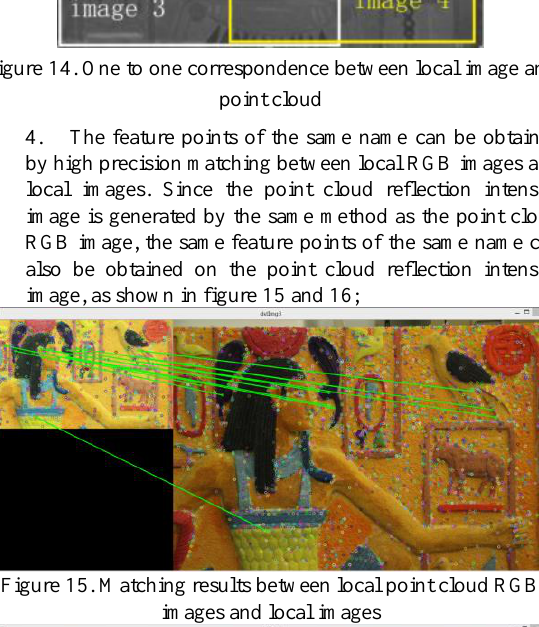
Figure 17. Color point cloud